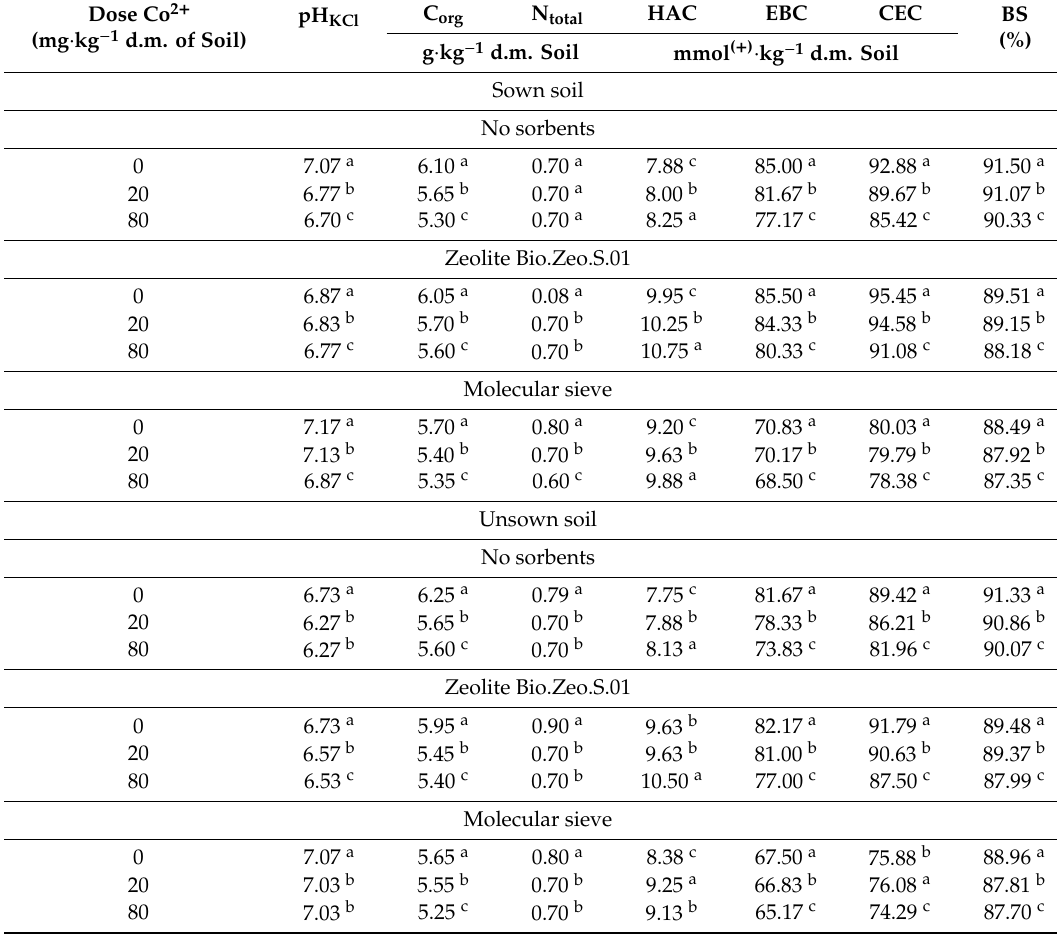
Table 16. Physicochemical properties of loamy sand, contaminated with cobalt, with the addition of a molecular sieve and